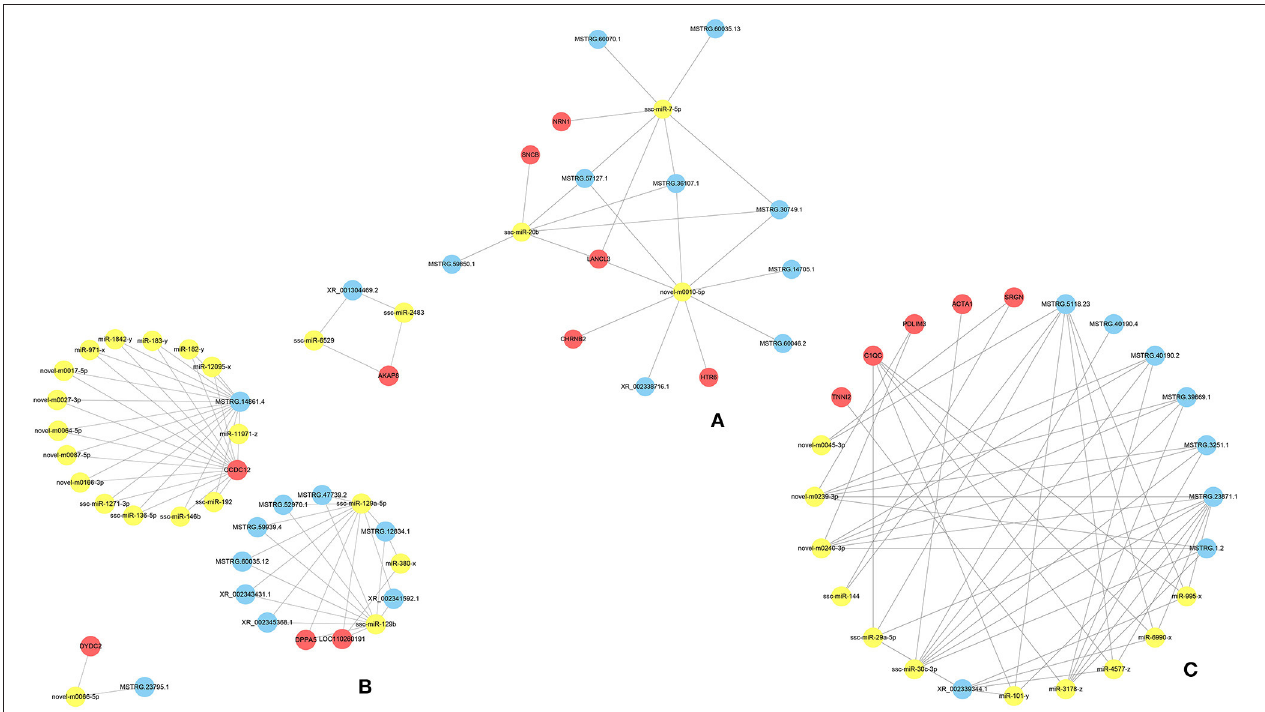
FIGURE 5 | The ceRNA coregulation network. The predicted lncRNA-miRNA-mRNA network constructed based on the lncRNA-mRNA and miRNA-mRNA pairs (A) between the normoxic (TN and LN) and hypoxic (TL and LL) groups, (B) TN and TL groups, and (C) LN and LL groups.